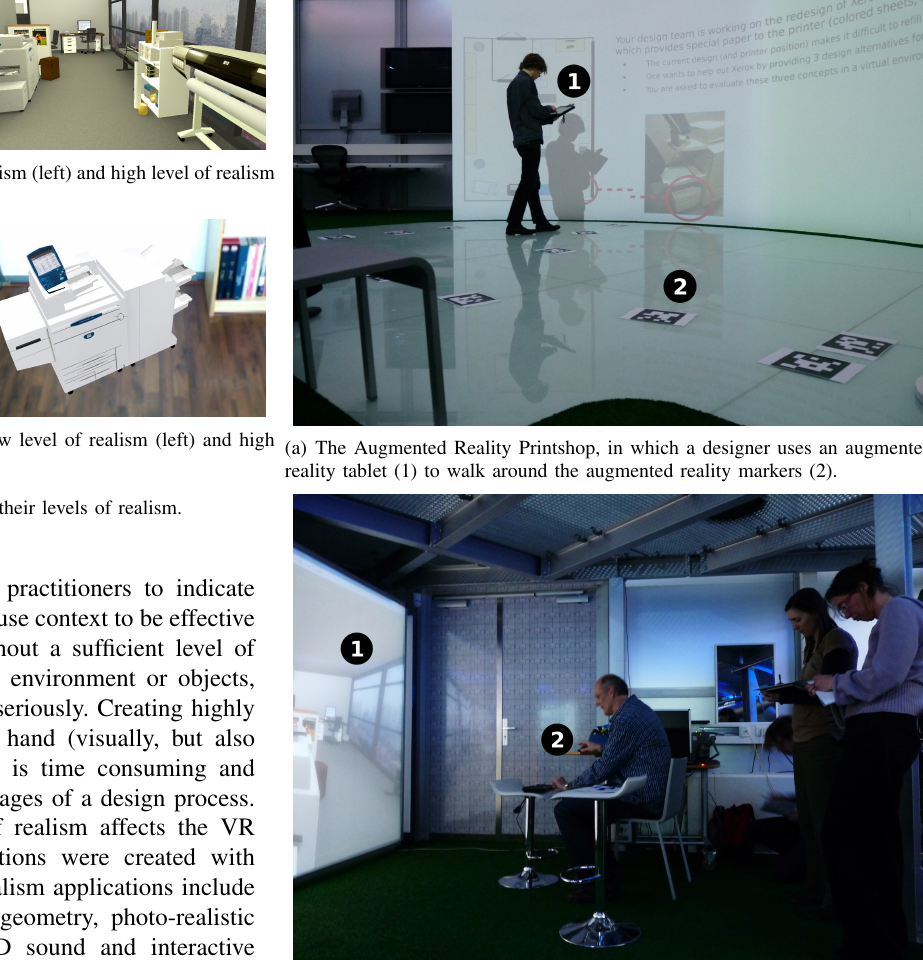
Fig. 5. The two prototypes of the virtual printshop in use during the application